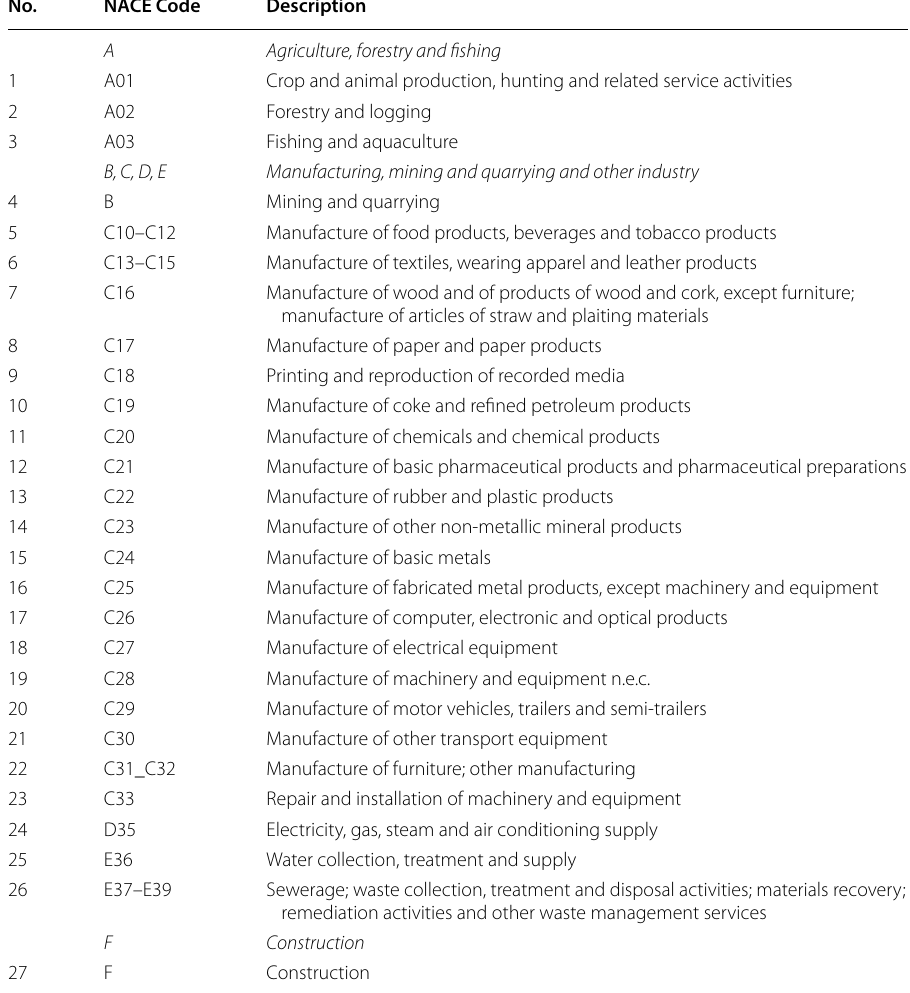
Table 5 Industry classification